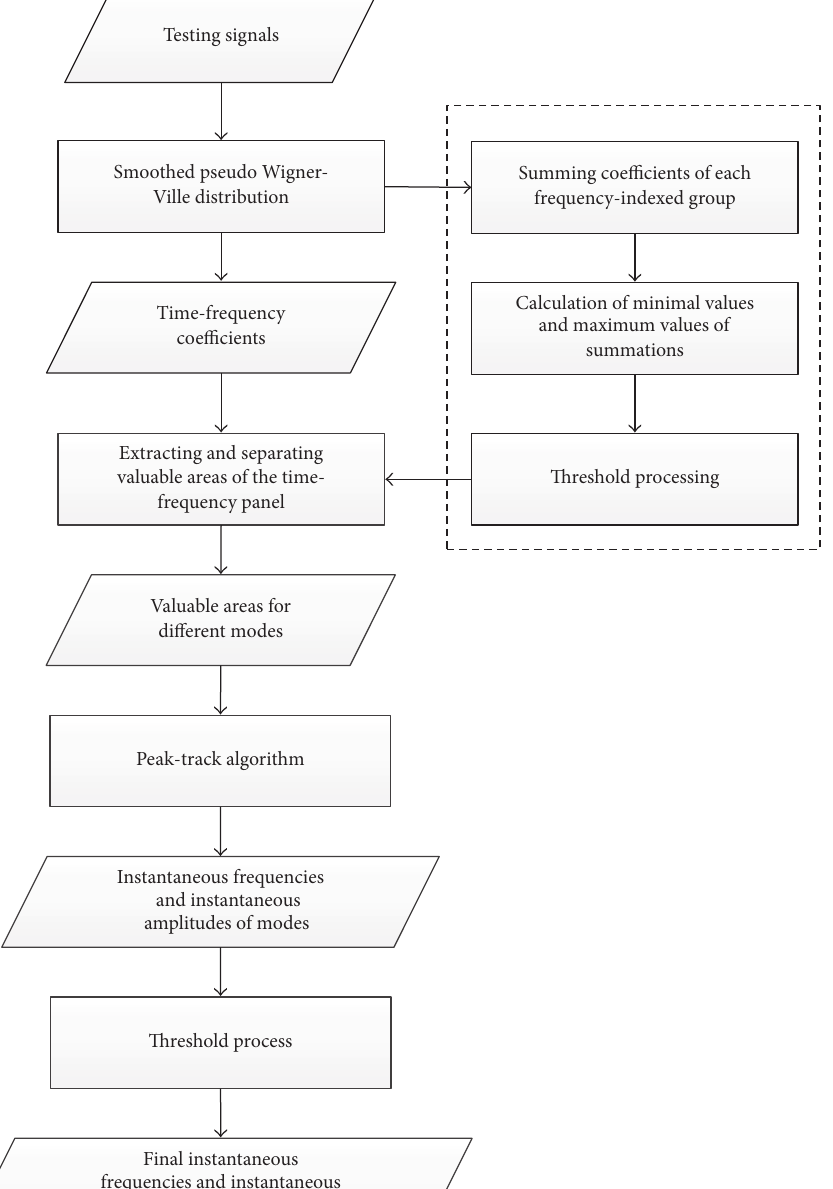
Figure 1: The different steps of the algorithm presented in the paper.